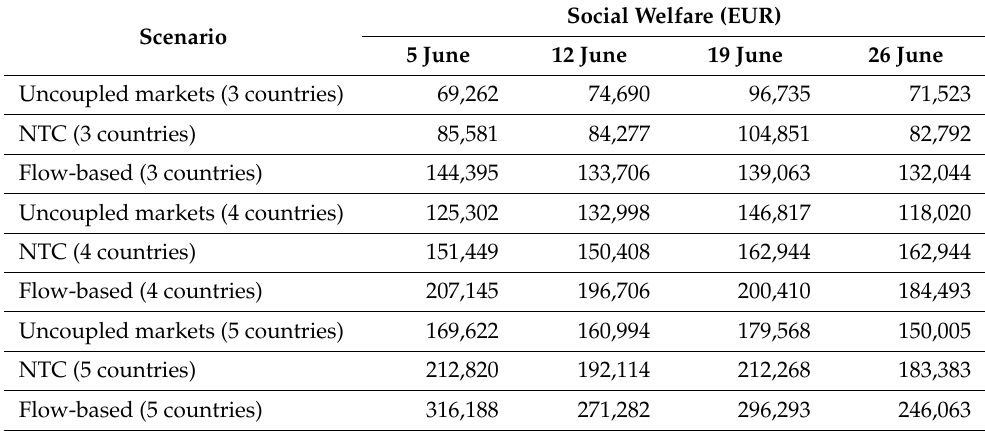
Table A1. Total social welfare for a typical hour of a typical